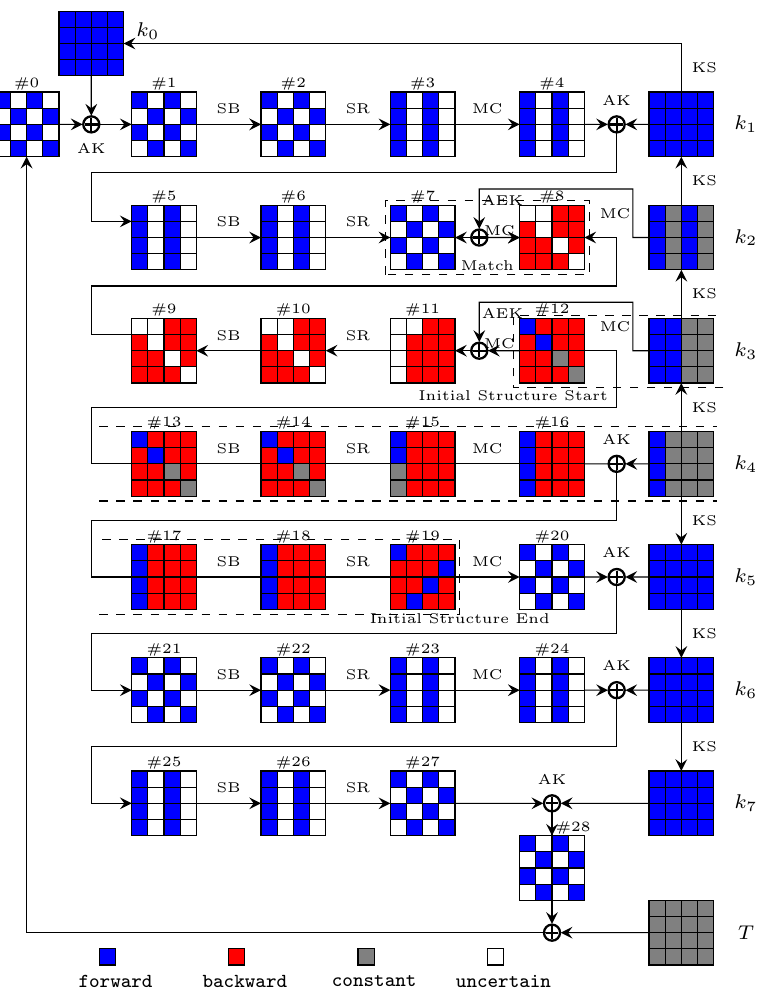
Figure 7: Introducing free bytes in the key to improve the 7-round preimage attack on AES -128 hashing